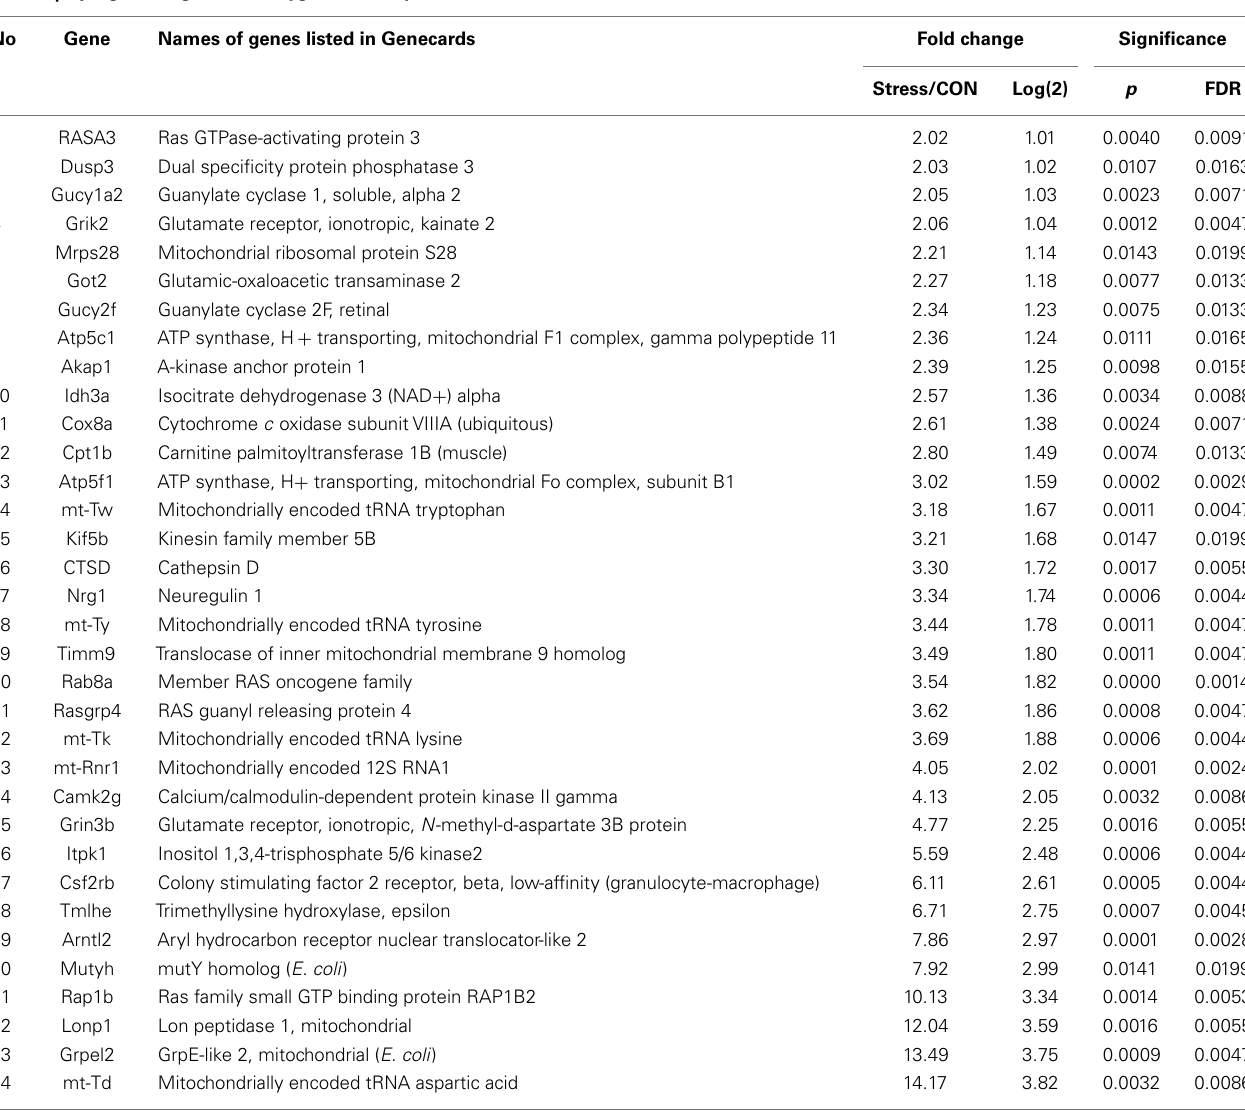
Table 2 | Upregulated genes in amygdala (14days after stress)